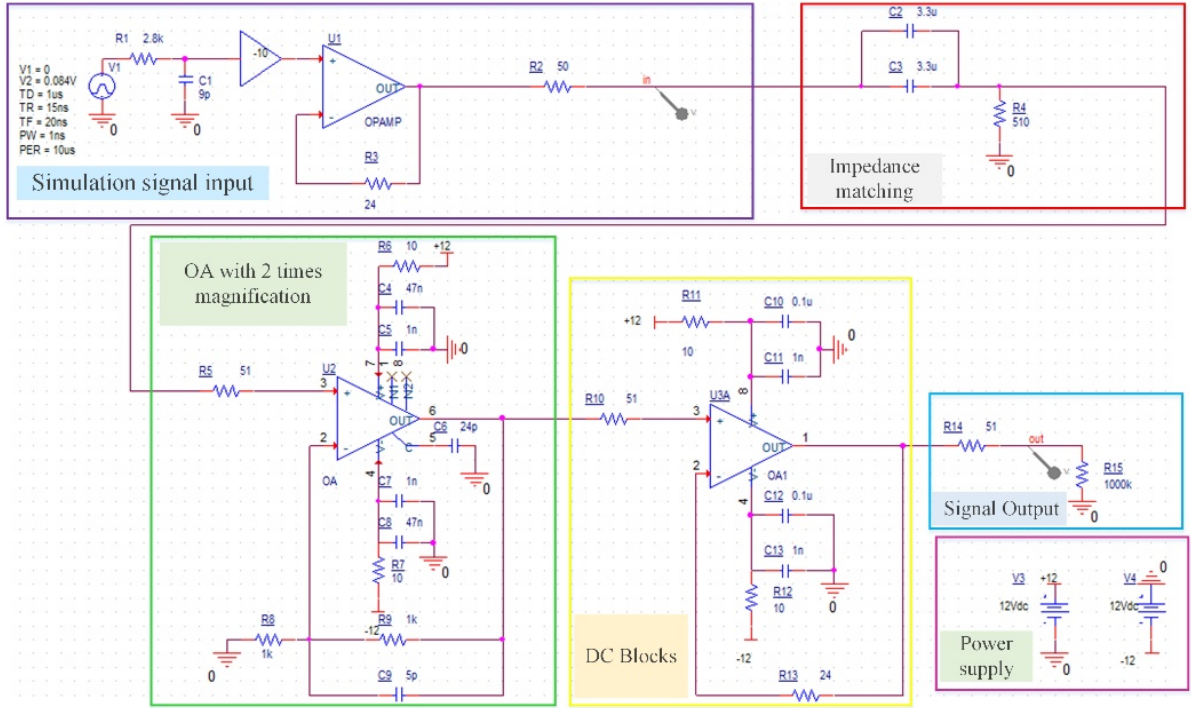
Figure 7. ( a ) The transfer model of the APD photoreceiver established by SIMULINK. ( b ) The laser pulse used to verify the accuracy of the transfer model. ( c ) The blue line is the direct output signal of the APD photoreceiver, the red line is the simulated signal output from the transfer model, and the cyan line is the simulation signal input to CADENCE simulation.